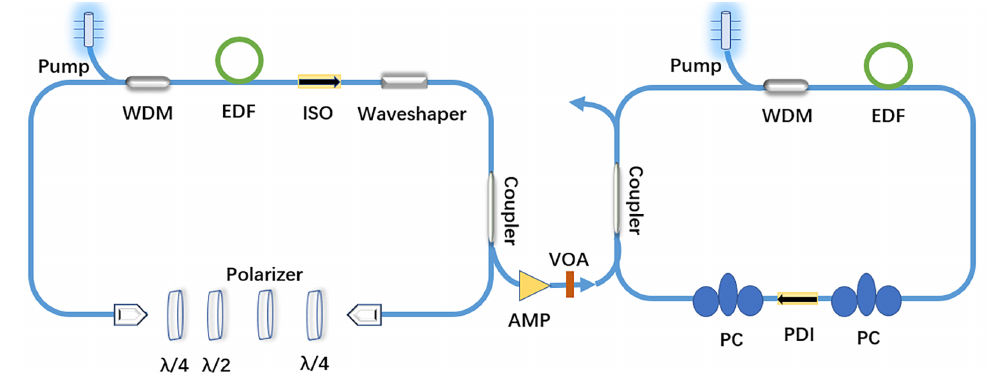
Figure 1. The experimental setup. WDM: wavelength-division multiplexer; EDF: erbium-doped fibre; ISO: isolator; AMP: amplifier; VOA: variable optical attenuator; PDI: polarisation-dependent isolator; PC: polarization